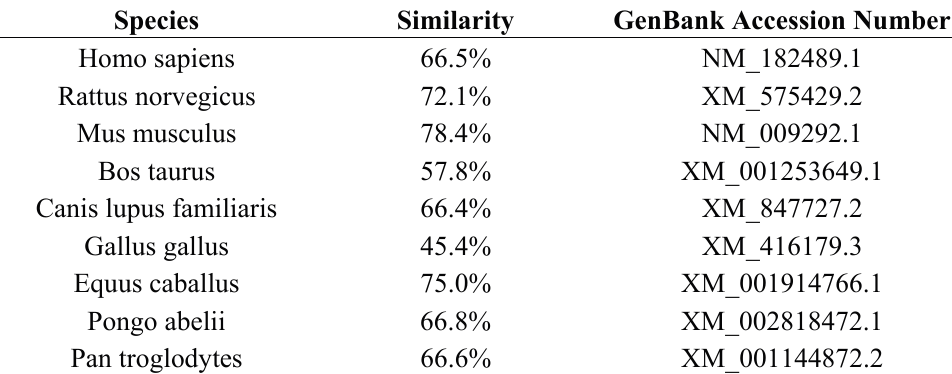
Table 1. Homology analyses of STRA8 amino acid sequence.